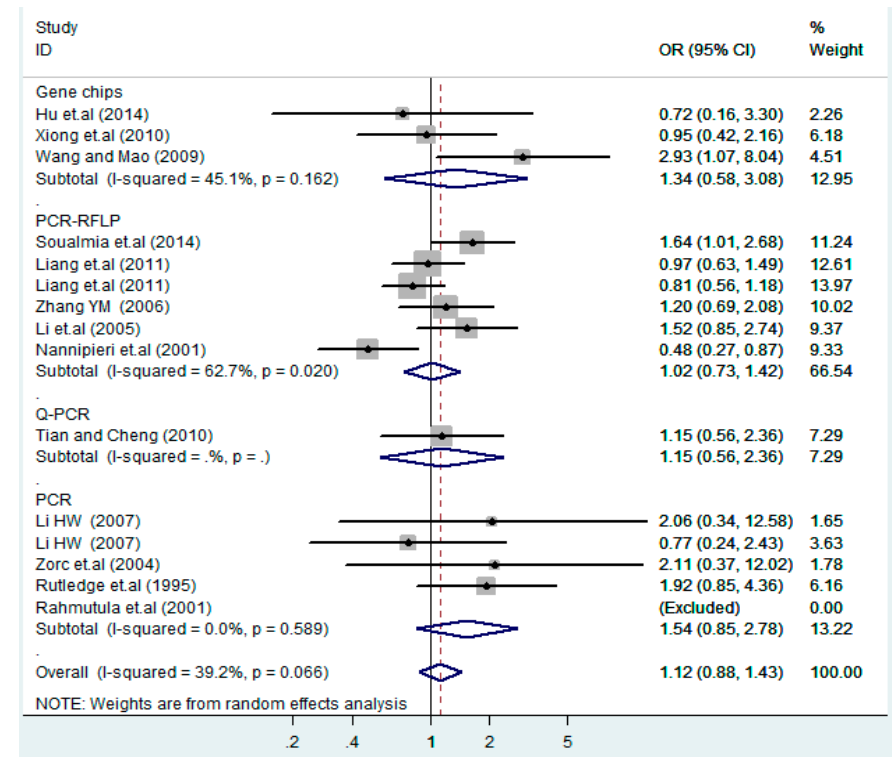
Figure 21. Subgroups of genotyping methods of T2238C co-dominant model-2 (CC vs. TT). Int. J. Environ. Res. Public Health 2016 , 13 , 458